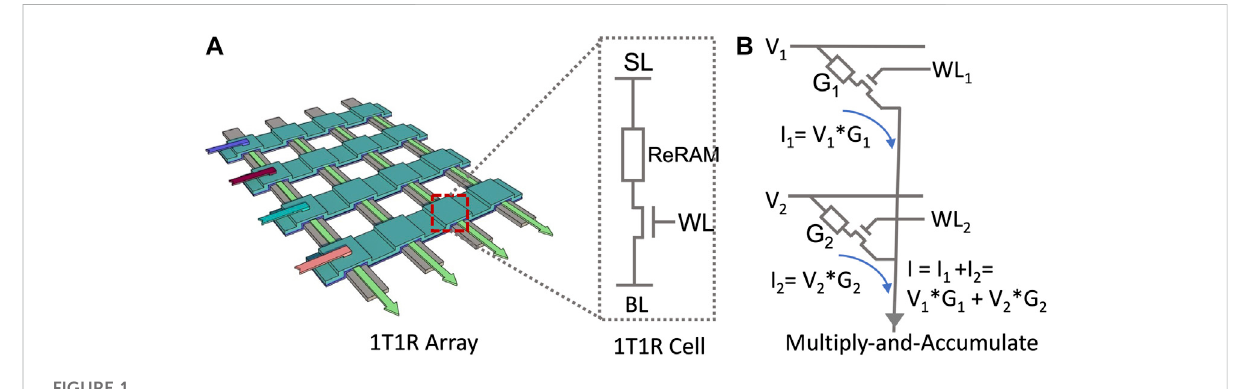
FIGURE 1 ReRAM 1T1R crossbar array (Zhang et al.,